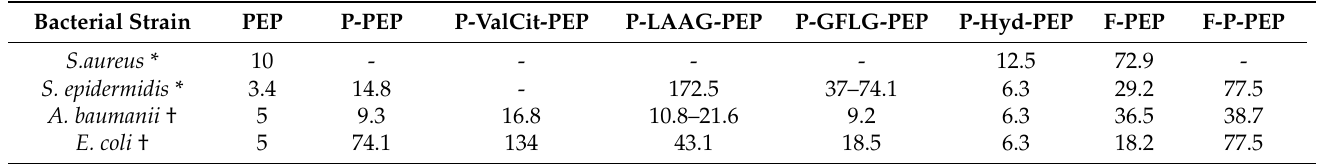
Table 3. The MIC ( µ M) of PEP and its polymer constructs. The MIC was determined as the lowest concentration of the construct that inhibited bacterial growth and the data represent the mean of at least three independent